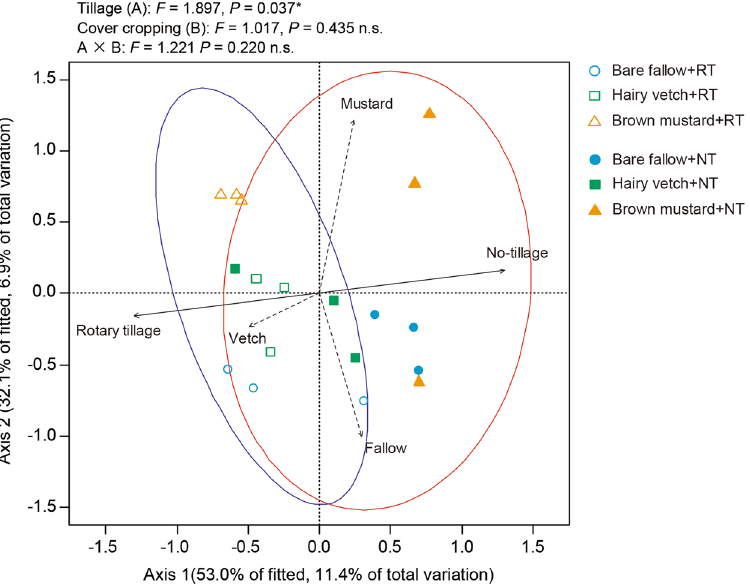
Figure 7. Influence of cover crop type and tillage management on the communities of arbuscular mycorrhizal fungi (AMF) in the maize roots according to distance-based redundancy analysis (db-RDA). Dashed lines explain the effect of each type of cover crop. RT: rotary tillage. NT: no tillage. Ellipses represent 95% confidence intervals. All analyses and Fig. 7 were run and created in the software environment RStudio (Version 1.2.1335 – © 2009–2019 RStudio, Inc.)